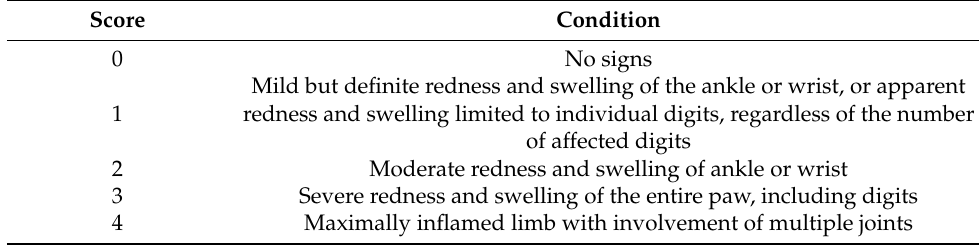
Table 3. Qualitative scoring system to assess the severity of CIA inflammation. Score Condition 0 No signs Mild but definite redness and swelling of the ankle or wrist, or apparent 1 redness and swelling limited to individual digits, regardless of the number of affected digits 2 Moderate redness and swelling of ankle or wrist 3 Severe redness and swelling of the entire paw, including digits 4 Maximally inflamed limb with involvement of multiple joints CIA, collagen-induced